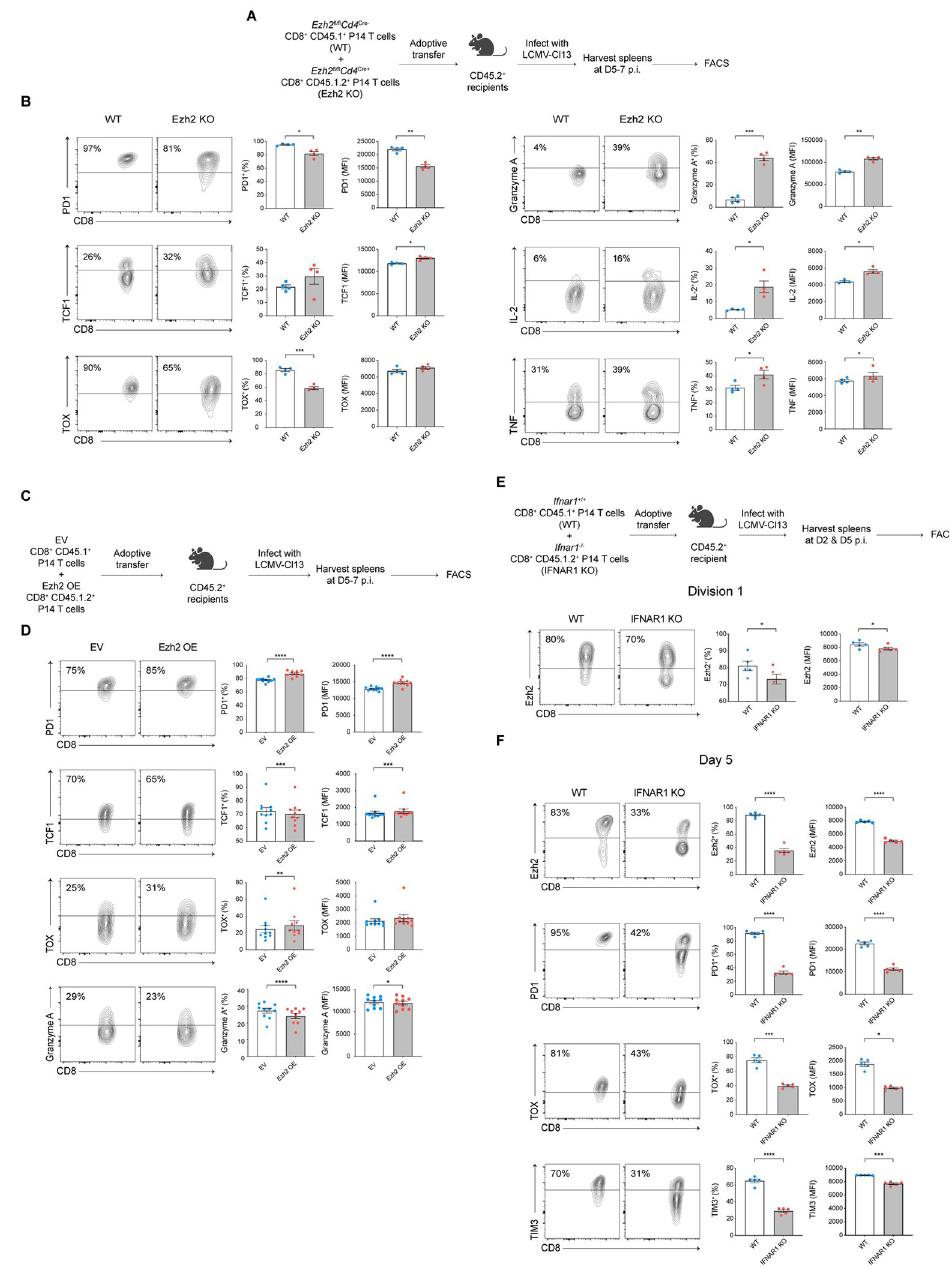
Fig 3. Ezh2-mediated epigenetic repression may partially influence exhaustion. ( A ) Experimental setup. Control CD45.1 + (wild-type, “WT”) and Ezh2-deficient CD45.1.2 + ( Ezh2 fl / fl Cd4 Cre+ , “Ezh2 KO”) CD8 + P14 T cells were cotransferred into congenically distinct CD45.2 + recipient mice prior to infection with LCMV-Cl13; recipient mice were killed at 5–7 days post-infection and splenocytes analyzed by flow cytometry. ( B ) Representative flow cytometry plots (left) displaying expression of PD1, TCF1, TOX, Granzyme A, IL-2, or TNF protein among gated donor WT or Ezh2 KO P14 T cells. Bar graphs indicate the frequencies (middle) or MFI (right) of WT (blue) or Ezh2 KO (red) P14 T cells responding to LCMV-Cl13. ( C ) Experimental setup. CD8 + P14 T cells were transduced with an empty vector control (EV, CD45.1 + ) or Ezh2 overexpression (Ezh2-OE, CD45.1.2 + ) construct prior to adoptive cotransfer into CD45.2 + recipient mice prior to infection with LCMV-Cl13; recipient mice were killed at 5–7 days post-infection and splenocytes analyzed by flow cytometry. ( D ) Representative flow cytometry plots (left) displaying expression of PD1, TCF1, TOX, and Granzyme A among gated donor EV or Ezh2-OE P14 T cells. Bar graphs indicate the frequencies (middle) or MFI (right) of EV (blue) or Ezh2-OE (red) P14 T cells expressing each molecule. ( E , F ) Control CD45.1 + (wild-type, “WT”) and IFNAR1-deficient CD45.1.2 + ( Ifnar1 -/- , “IFNAR1 KO”) CD8 + P14 T cells were labeled